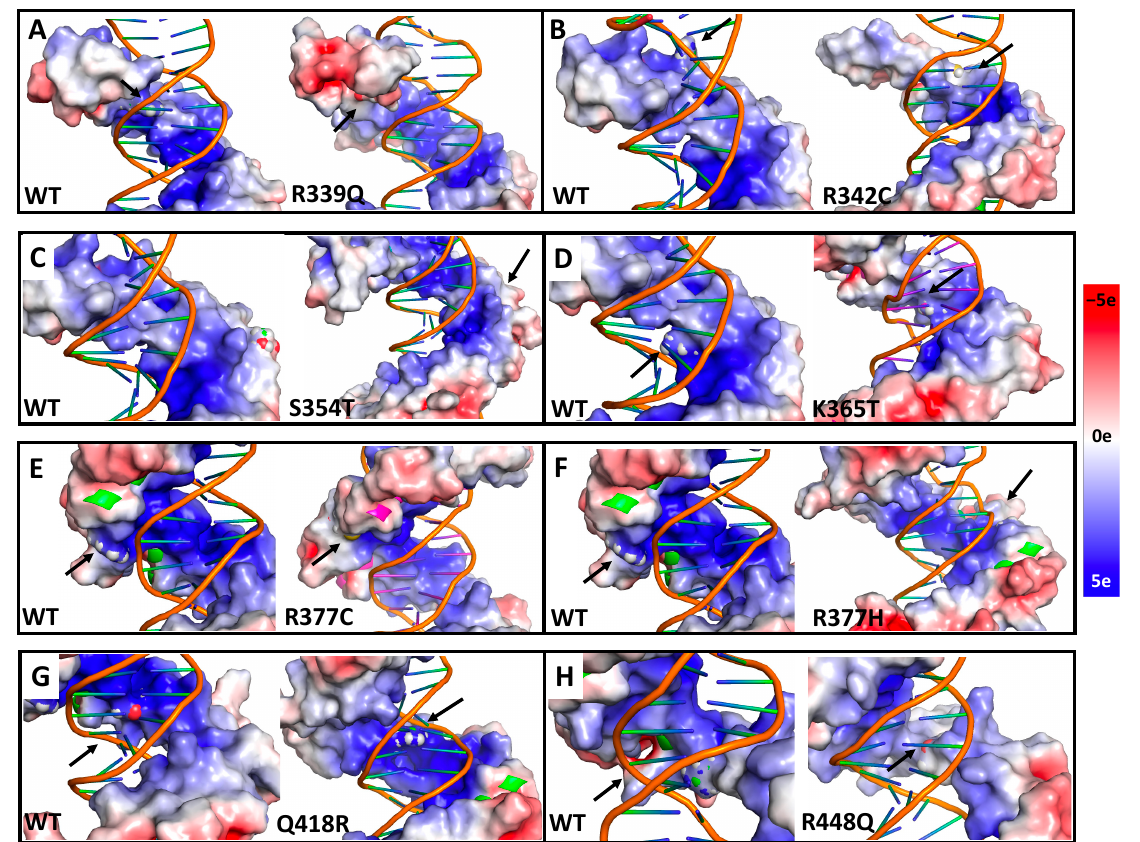
Figure 7. Single-residue mutations affect the electrostatic potential of CTCF. 3D structure of the most representative cluster for the WT (all panels), R399Q ( A ), R342C ( B ), S354T ( C ), K365T ( D ), R377C ( E ), R377H ( F ), Q418R ( G ), and R448Q ( H ) proteins, showing the electrostatic potential on the area surrounding the mutation. Color scale goes from 5e (blue) to 0e (white) to − 5e (red) (from basic to acidic). Arrows indicate the location of the mutation.